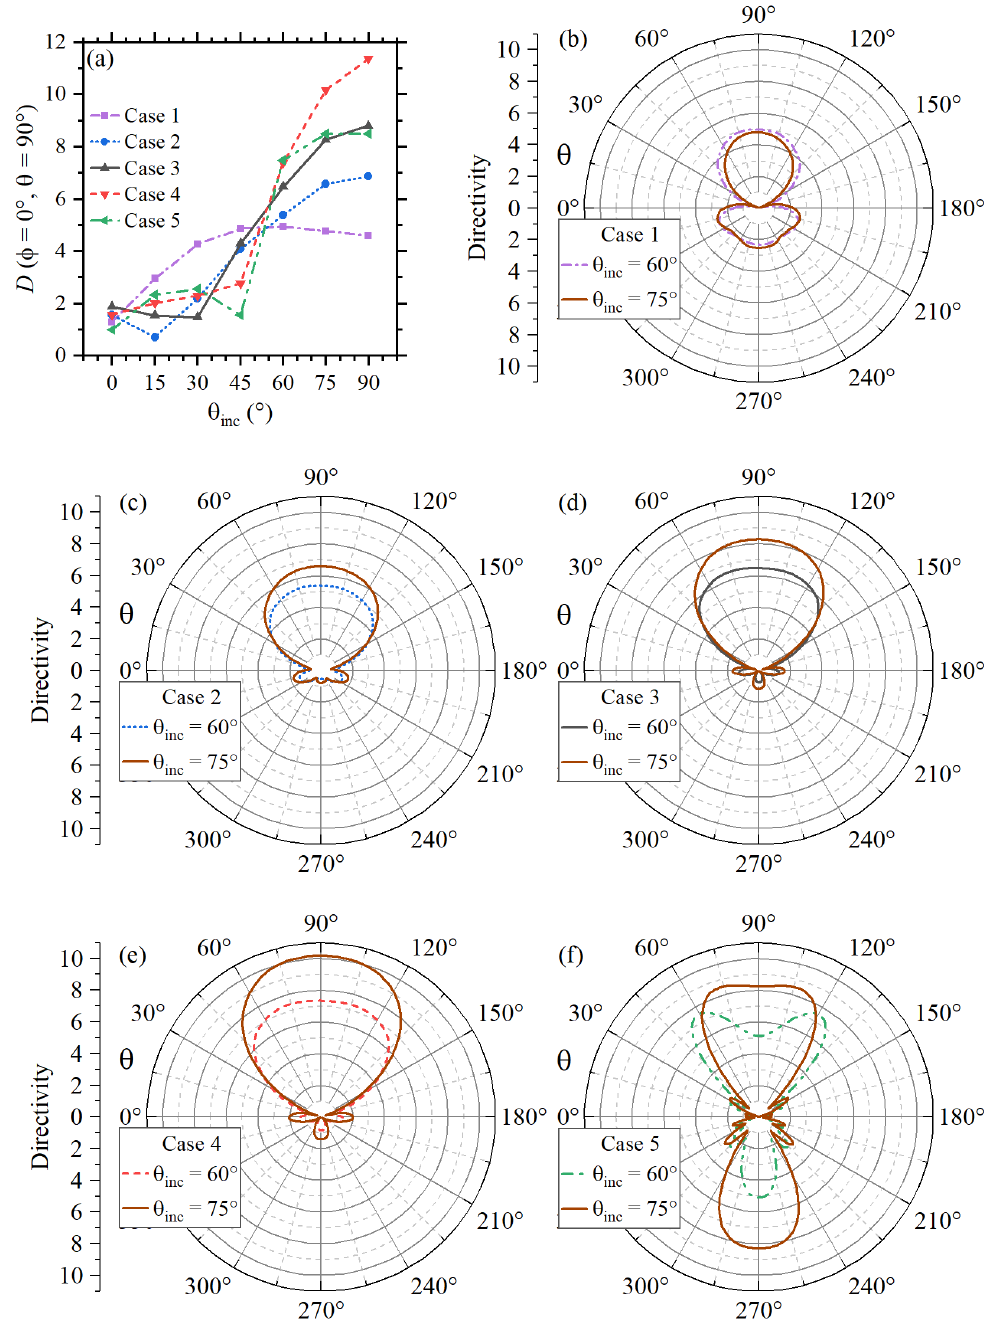
Figure 5. ( a ) Comparative analysis of directivity towards + x -axis [ D ( φ = 0 ◦ , θ = 90 ◦ ) ], as a function of θ inc , for all five cases. Numerical results of the corresponding far-field patterns for θ inc = 60 ◦ and θ inc = 75 ◦ are comparatively plotted in ( b – f ) for all five cases,